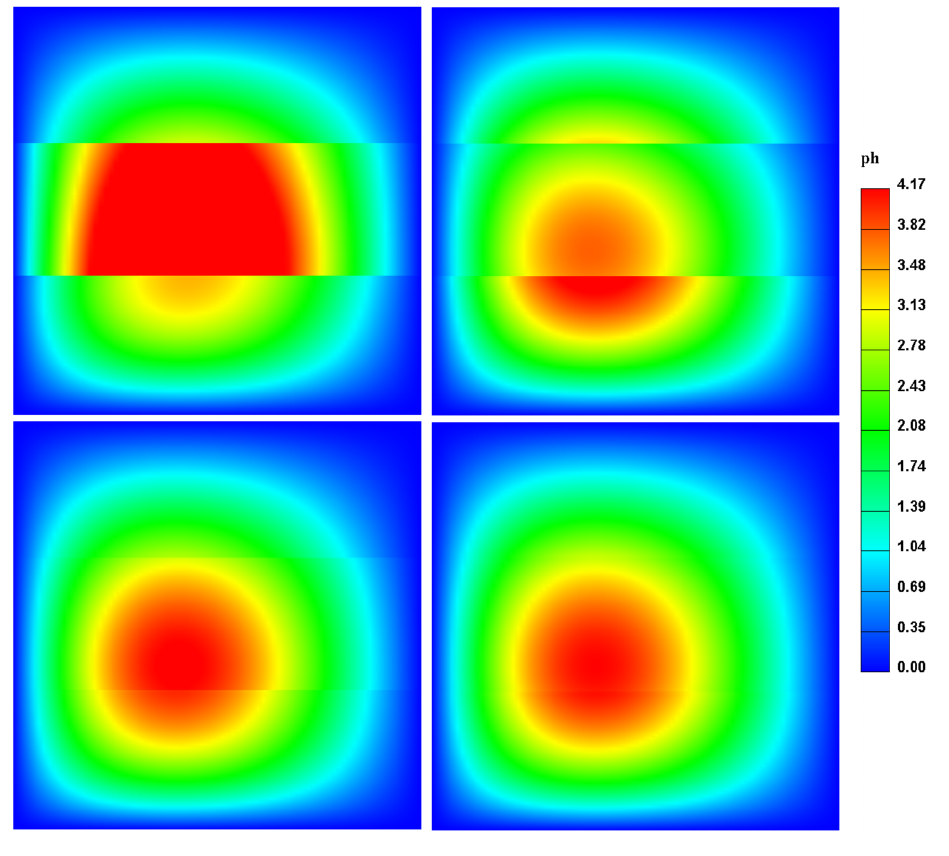
Figure 14: DN snapshots to solving (25) with pressure field (27) Figure 14. DN snapshots to solving (25) with pressure field (27).